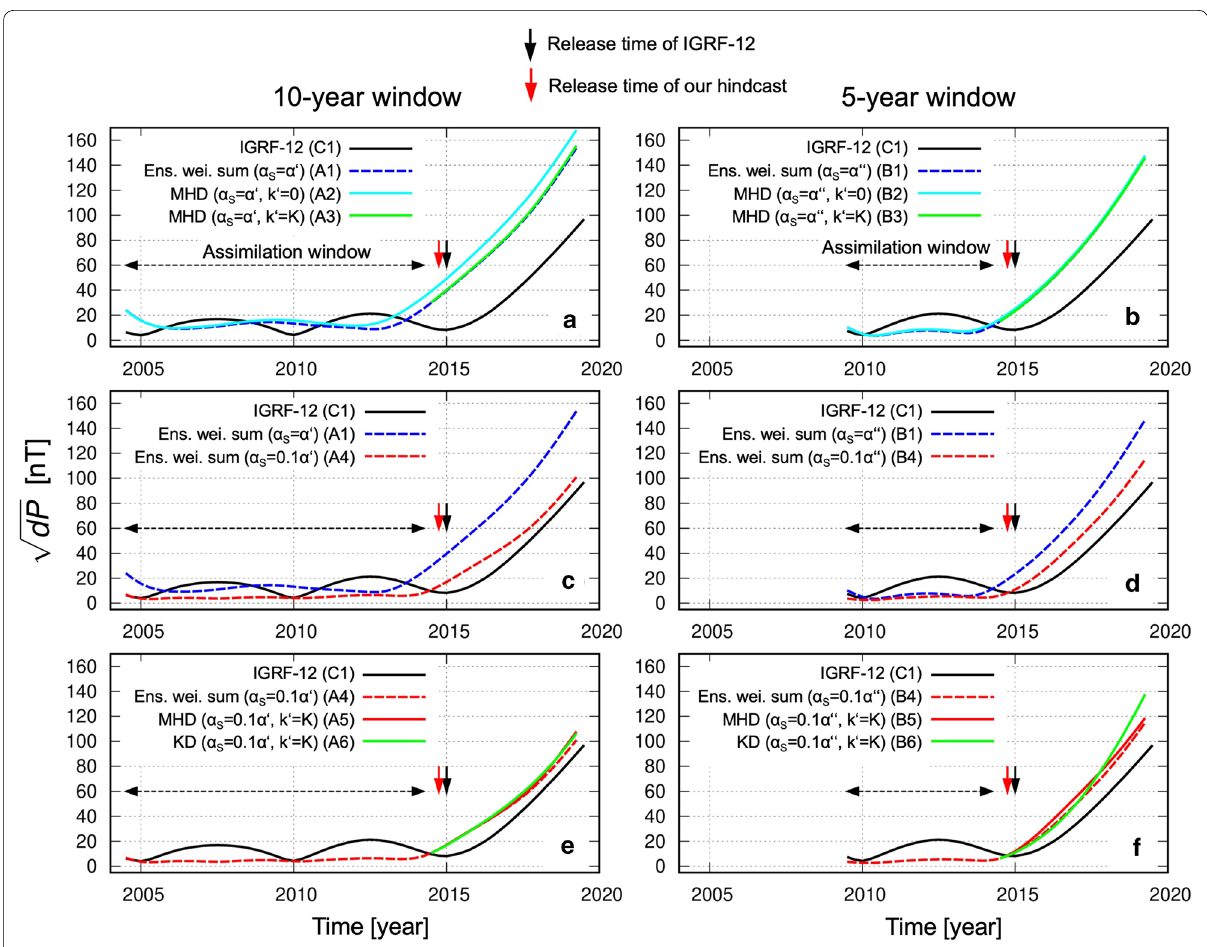
Fig. 6 Time evolutions of √ d P (Eq. 40) for the numerical experiments (see Table 1 for the summary). Left and right columns show results of 10-year and 5-year assimilation windows, respectively. All ordinates are √ d P , i.e., the metric for deviation from the MCM6 model. The 10-year window spans 14 ) in the left and α 7 ) in the right indicate α from 2004.50 to 2014.25, while the 5-year one from 2009.50 to 2014.25. α ′ ( S (Eq. 39) adopted ′′ ( = = in the final 5th iteration. a , b The weighted sum of ensemble members by Eq. (13) (the Ens. wei. sum) and MHD dynamo simulation starting from 0 ) or the end ( k 0 ) of the assimilation window (see Eqs. 14–16) (the MHD forecasts). c , d The optimized initial conditions at the beginning ( k ′ ′ = = dependence on the weight coefficient, α S (Eq. 39), where the red dashed lines show the results with 0.1 α ′ and 0.1 α ′′ . e , f The ensemble-weighted K ) for 0.1 α ′ and 0.1 α ′′ . sum, MHD dynamo, and KD simulations starting at the end of assimilation window (the MHD and KD forecasts with k ′ = In all the panels, the black solid lines indicate √ d P calculated between the MCM6 model and IGRF-12. The release time for our forecast, assumed 0.5 year after the end of the assimilation window, is 2014.75, while 2015.00 for